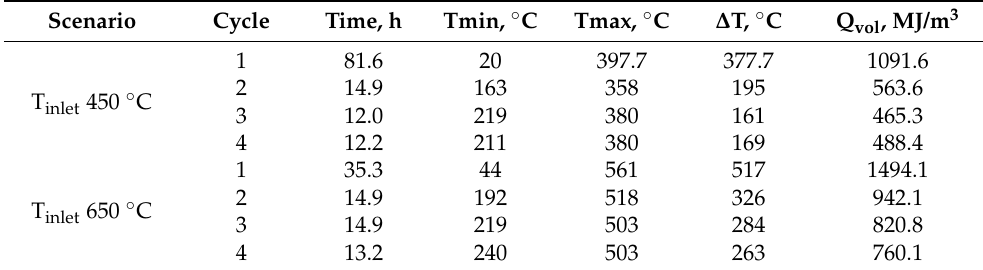
Table 4. Summary of data obtained during experiments (GEO).